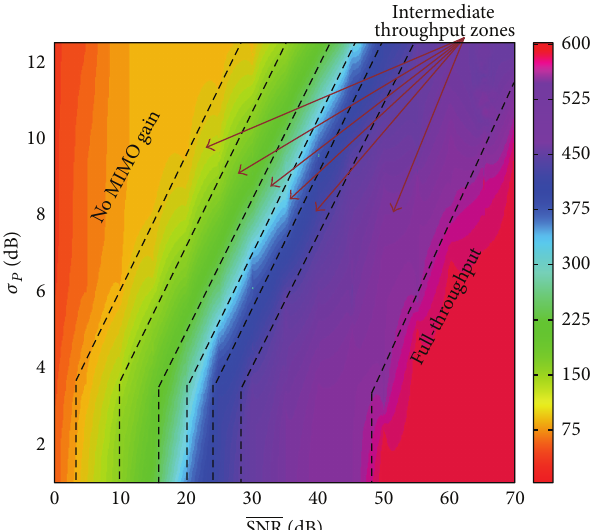
Figure 5: Downlink throughput values provided by the LTE-A link-level simulator for the 8 × 8 i-MIMO case as a function of average SNR and 𝜎 𝑃